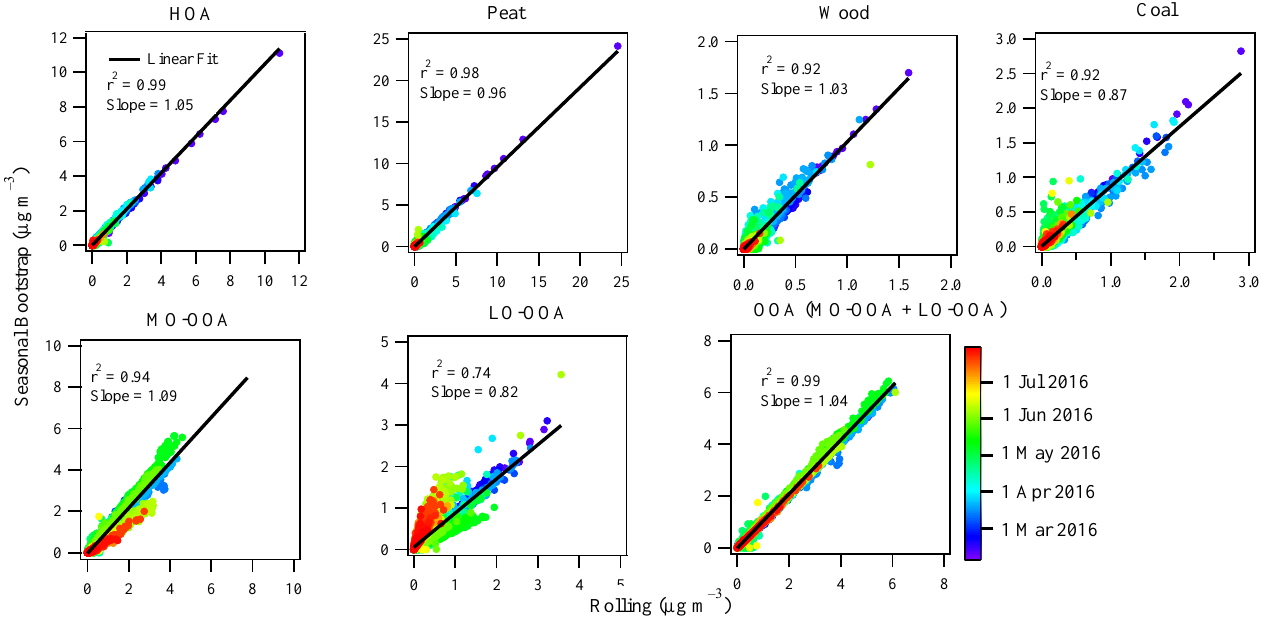
Figure 7. Scatter plot between the time series of the OA factors resolved by the seasonal PMF (y-axis) and rolling PMF (x-axis), color coded by date. The correlation r 2 and slope for the linear fit are also shown for each factor.